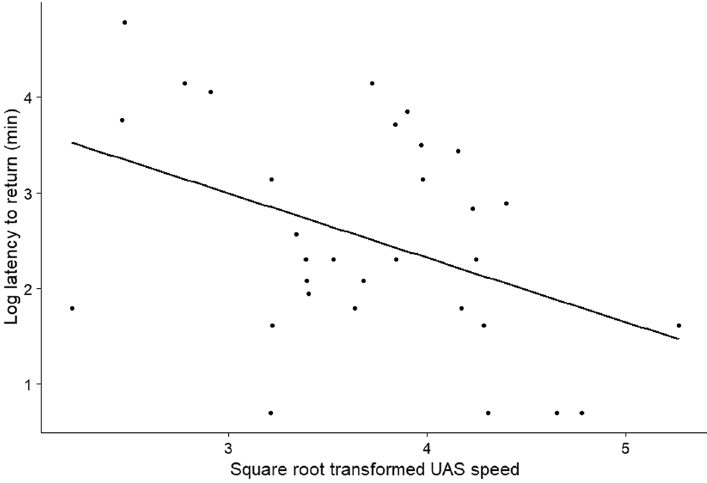
Figure 6. Relationship between vulture latency to return to the study area on the ground and UAS approach